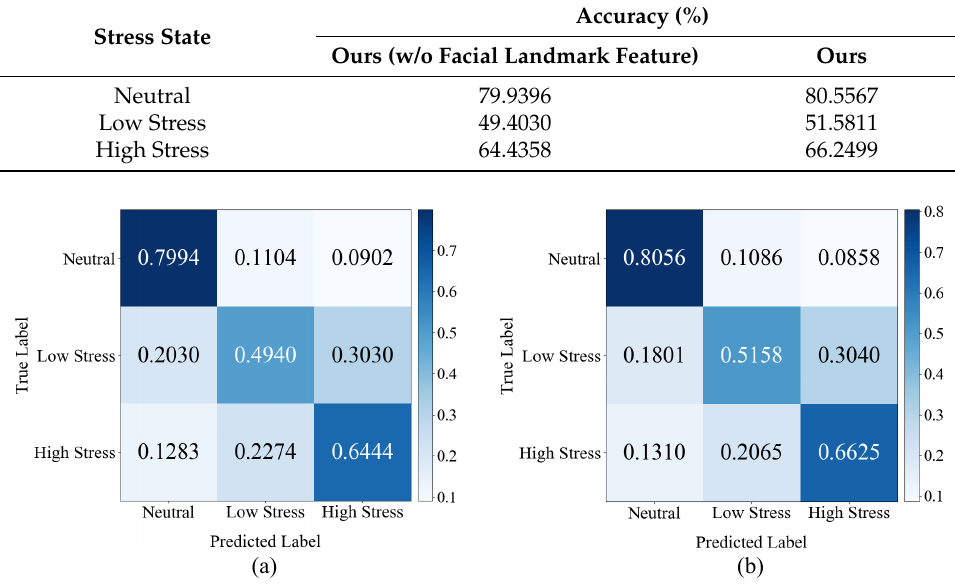
Figure 9. Confusion matrix of the proposed method ( a ) without and ( b ) with the facial landmark